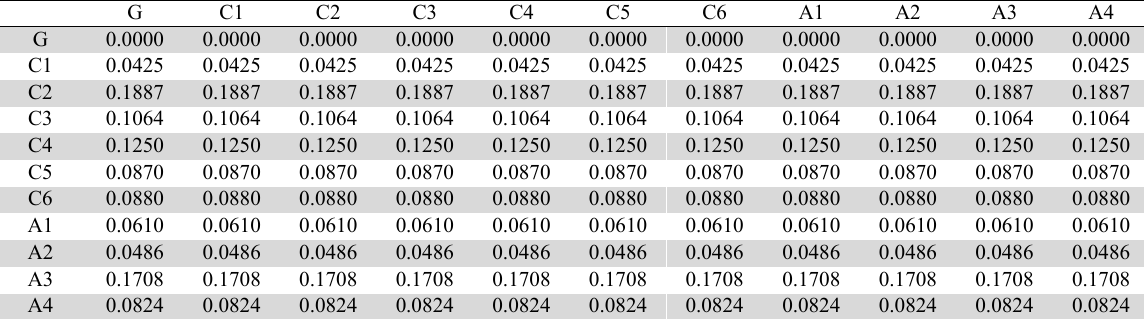
Limiting Super-matrix